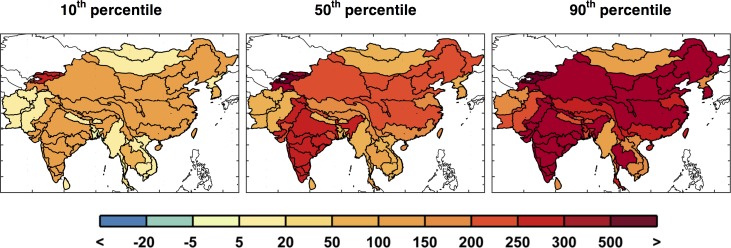
As in Fig 19, but for industrial water requirement shown for the 10th, median, and 90th percentiles for each ASR.